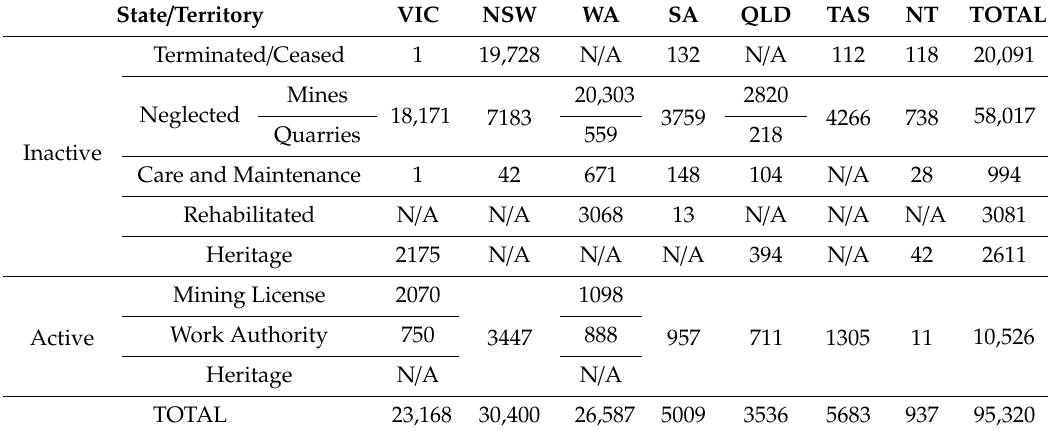
Table 3. Australian mine sites and mineral occurrences within the developed national